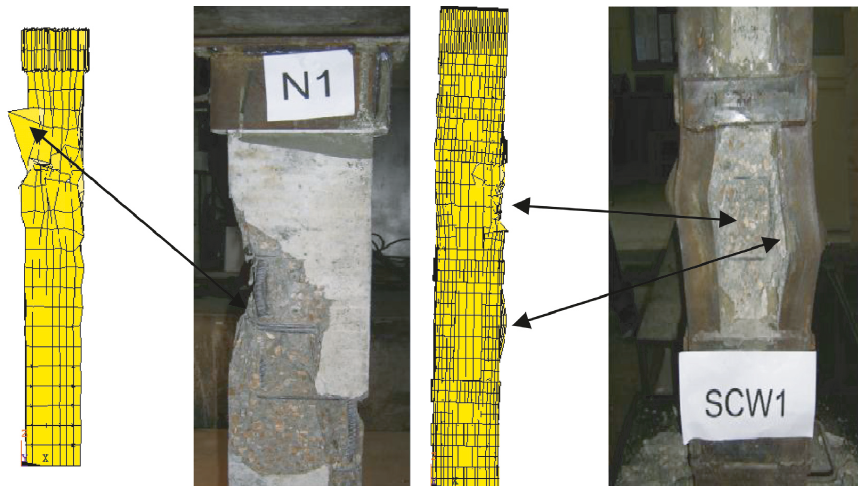
Figure 6: Deformations, failure modes, and locations obtained from both experimental Tarabia and Albakry [4] and FE results.